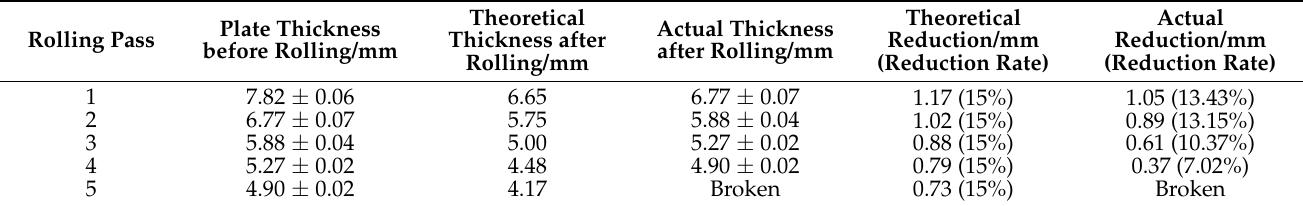
Table 2. Theoretical and practical scheme of rolling process parameters.